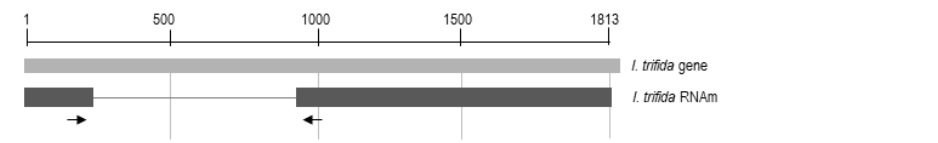
and Ib-CHI5 (blast e-value: 5e -91 and 3e -16 with AB037396.1, respectively), whereas no sequence homology was detected in the intron region with the GenBank database. No sequence homology was detected for Ib-CHI3 bands since only the intronic region was sequenced. Ib-CHI1 primer amplified one monomorphic band, Ib-CHI3 amplified three bands (two monomorphic and one polymorphic, present in “30BG” parent), whereas Ib-CHI5 amplified one monomorphic and one polymorphic band (present in “30BG”).